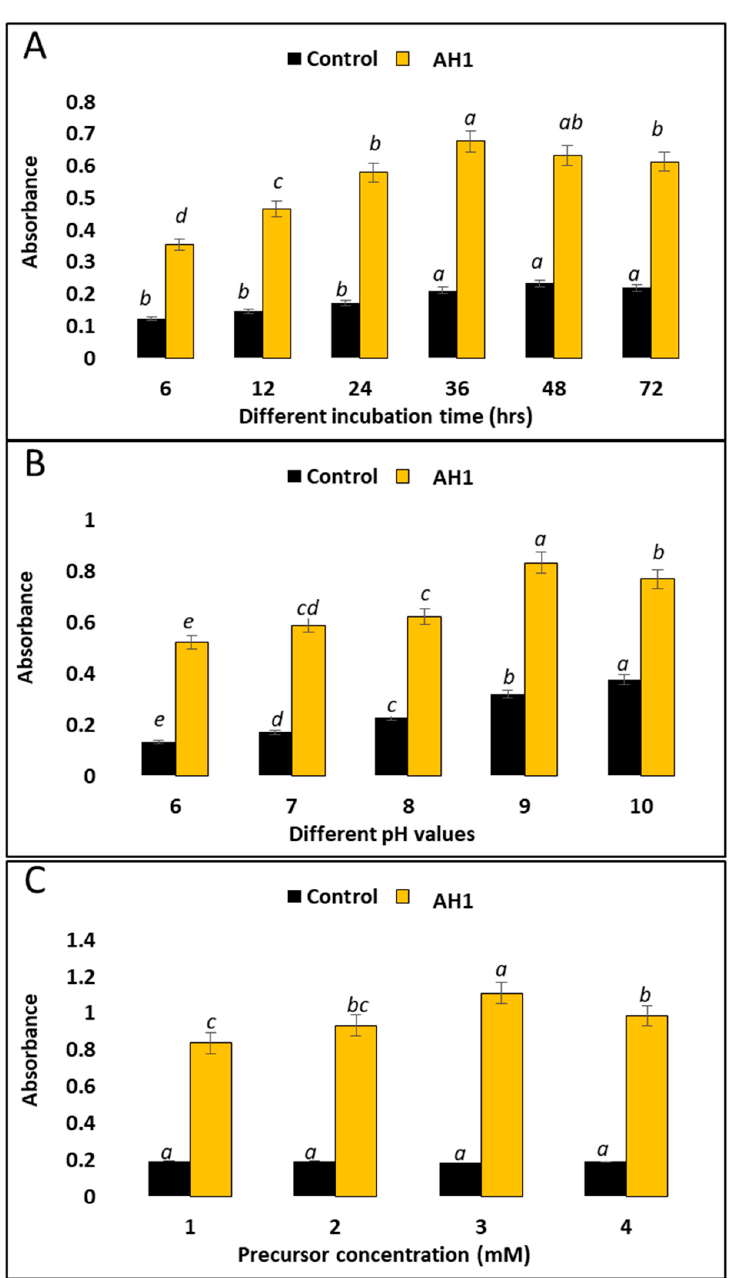
Figure 2. Optimizing factors for biosynthesized Hem-NPs using A. niger AH1: ( A ) the effect of the contact time between the biomass filtrate and 1.0 mM of FeSO 4 · 7H 2 O concentration, ( B ) the effect of different pH values, and ( C ) the effect of different FeSO 4 · 7H 2 O concentrations. Small letters a, b, c, d, ab, bc, cd show the power of